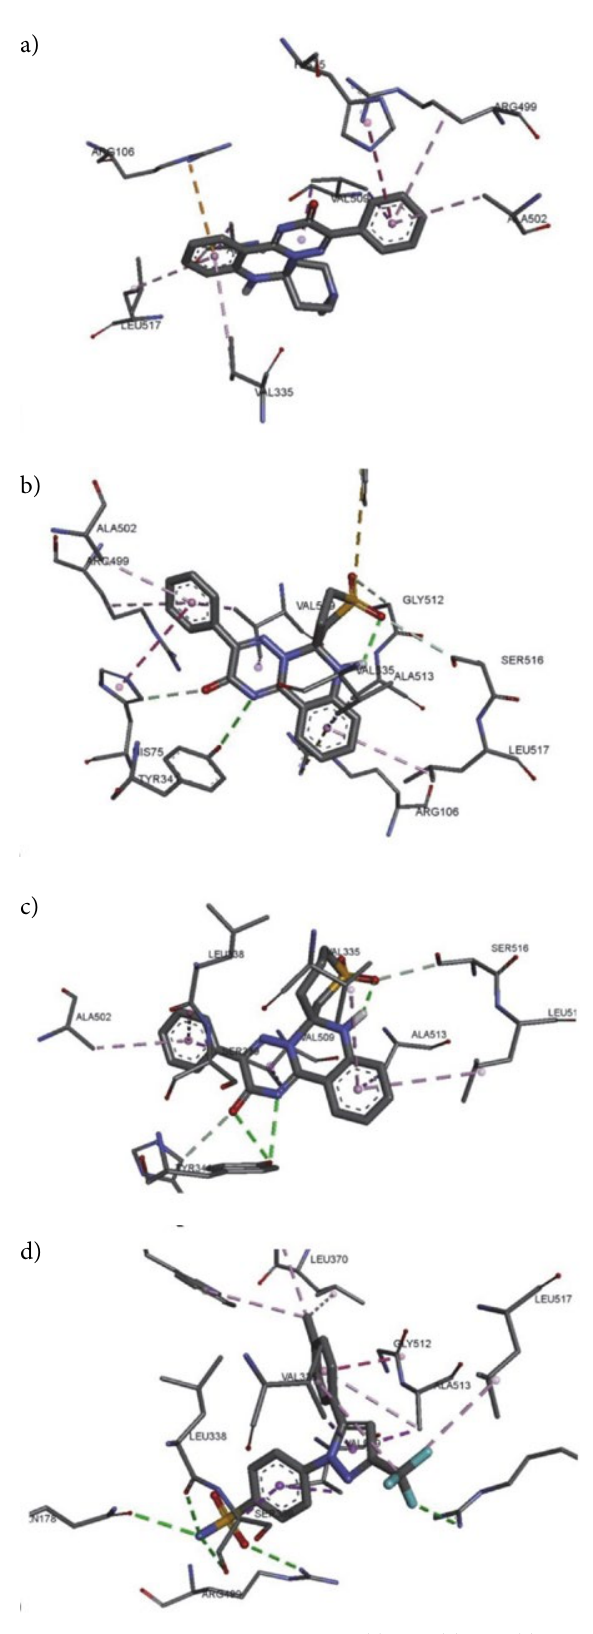
Figure 1. Interaction of compound 2.2 (a), 2.10 (b), 2.11 ( c ), cel- ecoxib ( d ) with COX-2, PDB ID: